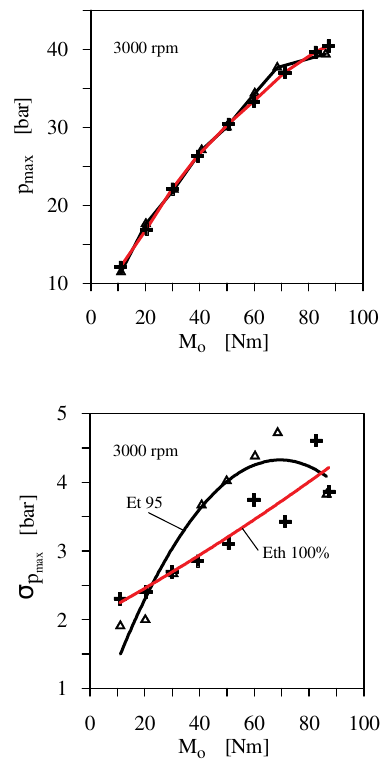
Fig. 5. Comparison of average value of maximal combustion pressures and mean standard deviation of combustion pressures in the Fiat 1100 MPI engine fueled with Et 95 gasoline and Eth 100% ethyl